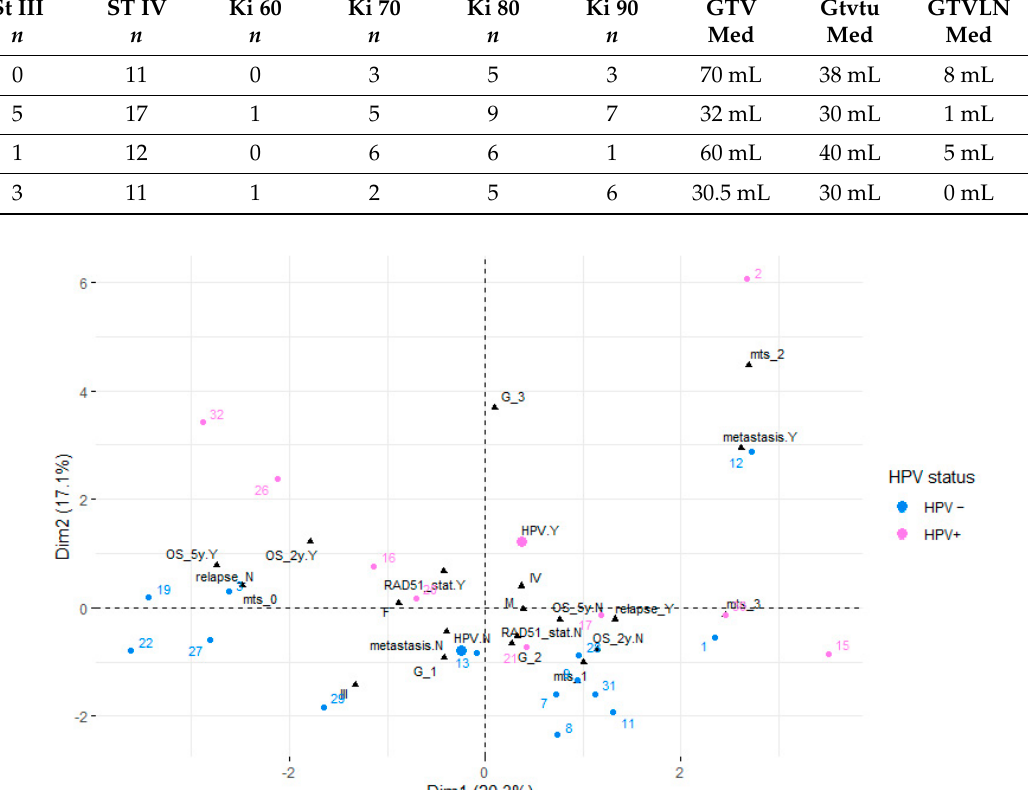
Figure 6. Factor analysis for mixed data showing the first factor plane. Individuals are colored depending on their HPV status.